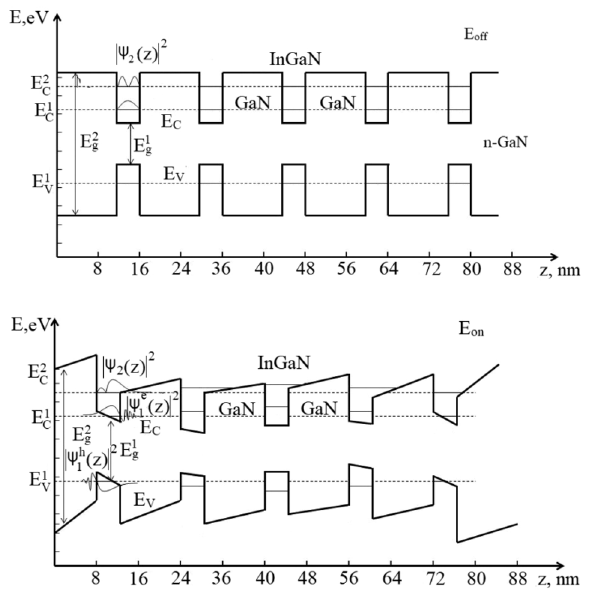
Fig. 5 A scheme of a zone diagram of an active layer consisting of 5 InGaN/GaN quantum wells: a With no applied electric field and without taking into account built-in fields. EV, EC are the maximum possible efficiency of the valence zone and the lowest possible efficiency of conductivity zone, respectively; b When reverse bias of p-n transition is applied. The oscillations and the Franz–Keldysh effect are shown within 1 QW. Square modules of wave functions of holes 𝜓 h and electrons 𝜓 e respectively in the valence region and in 1 1,2 the conductivity zone